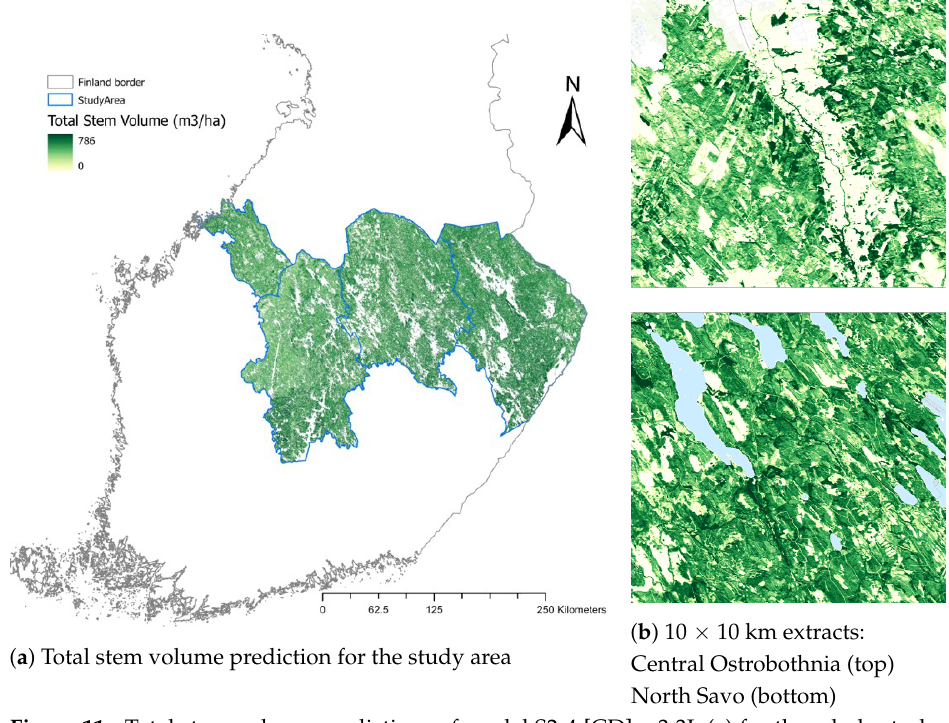
Figure 11. Total stem volume predictions of model S2-4 [CD] w3 3L ( a ) for the whole study area, and ( b ) for two 10 km × 10 km close-ups from Central Ostrobothnia ( top ) and North Savo ( bottom ).